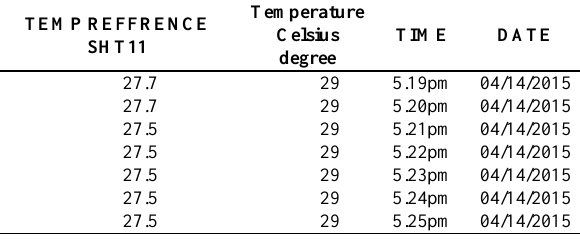
Table 1. An example of temperature values logged in Excel files (TEMP1, TEMP2).